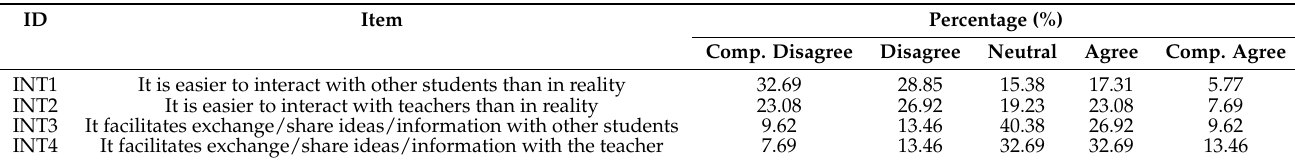
Table 5. Numerical results for ‘Interactivity’.